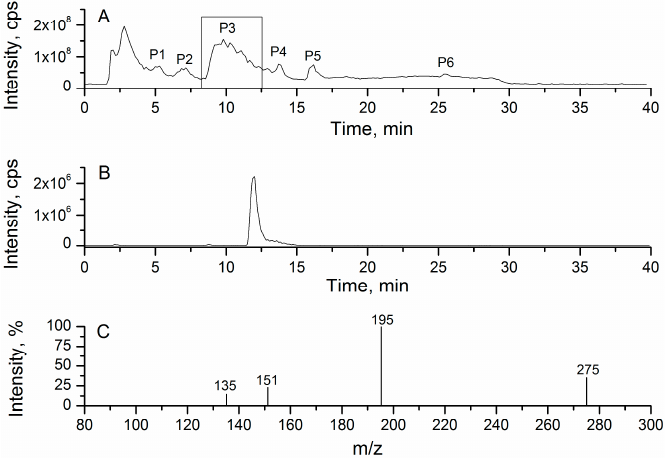
Figure 3. ( A ) TIC of mixture after synthesis of dihydroferulic acid-4- O -sulfate; ( B ) chromatogram of dihydroferulic acid-4- O -sulfate obtained after purification; ( C ) fragmentation spectra of dihydrofer- ulic acid-4- O -sulfate.